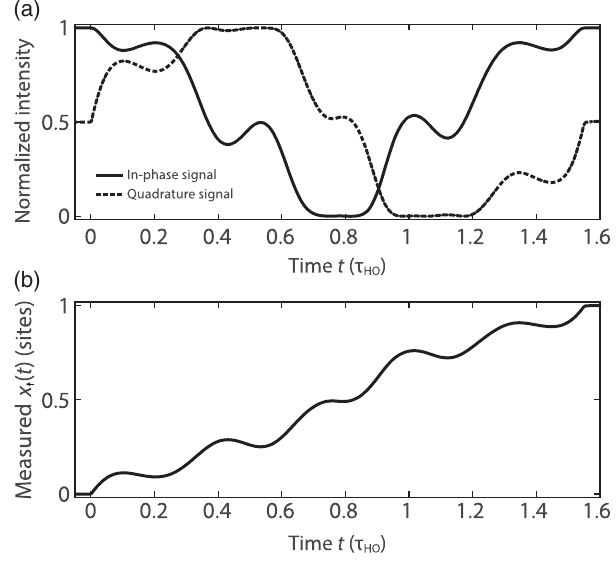
FIG. 5. Optical interferometric measurement of the trap tra- jectory. (a) Phase quadrature measurement of ϕ R ð t Þ , showing the normalized intensities recorded after a Glan-Laser polarizer for the in-phase, f 1 þ cos ½ ϕ R ð t Þ(cid:3)g = 2 , and the quadrature signal, f 1 þ sin ½ ϕ R ð t Þ(cid:3)g = 2 . (b) Displacement x ↑ ð t Þ ¼ ð λ = 2 Þ ϕ R ð t Þ = ð 2 π Þ of the optical conveyor belt, reconstructed from the in-phase and quadrature